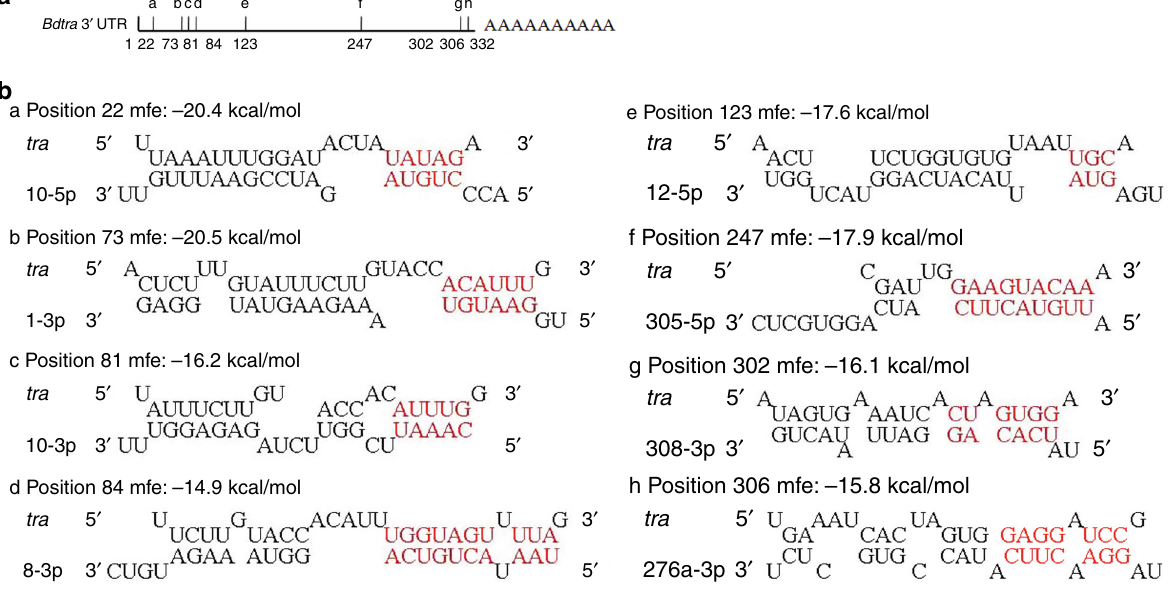
Fig. 2 miRNAs that potentially target the Bd tra gene. a The position of miRNAs putative binding sites in the 3 ′ UTR of Bdtra , and ( b ) RNA-RNA duplexes of potential miRNA with the Bdtra gene as detected by RNA hybrids. miRNA seed sequences and their putative binding sites in the 3 ′ UTR are indicated by red. mfe: match free 67% (Supplementary Fig. 1B), consistent with one of the most